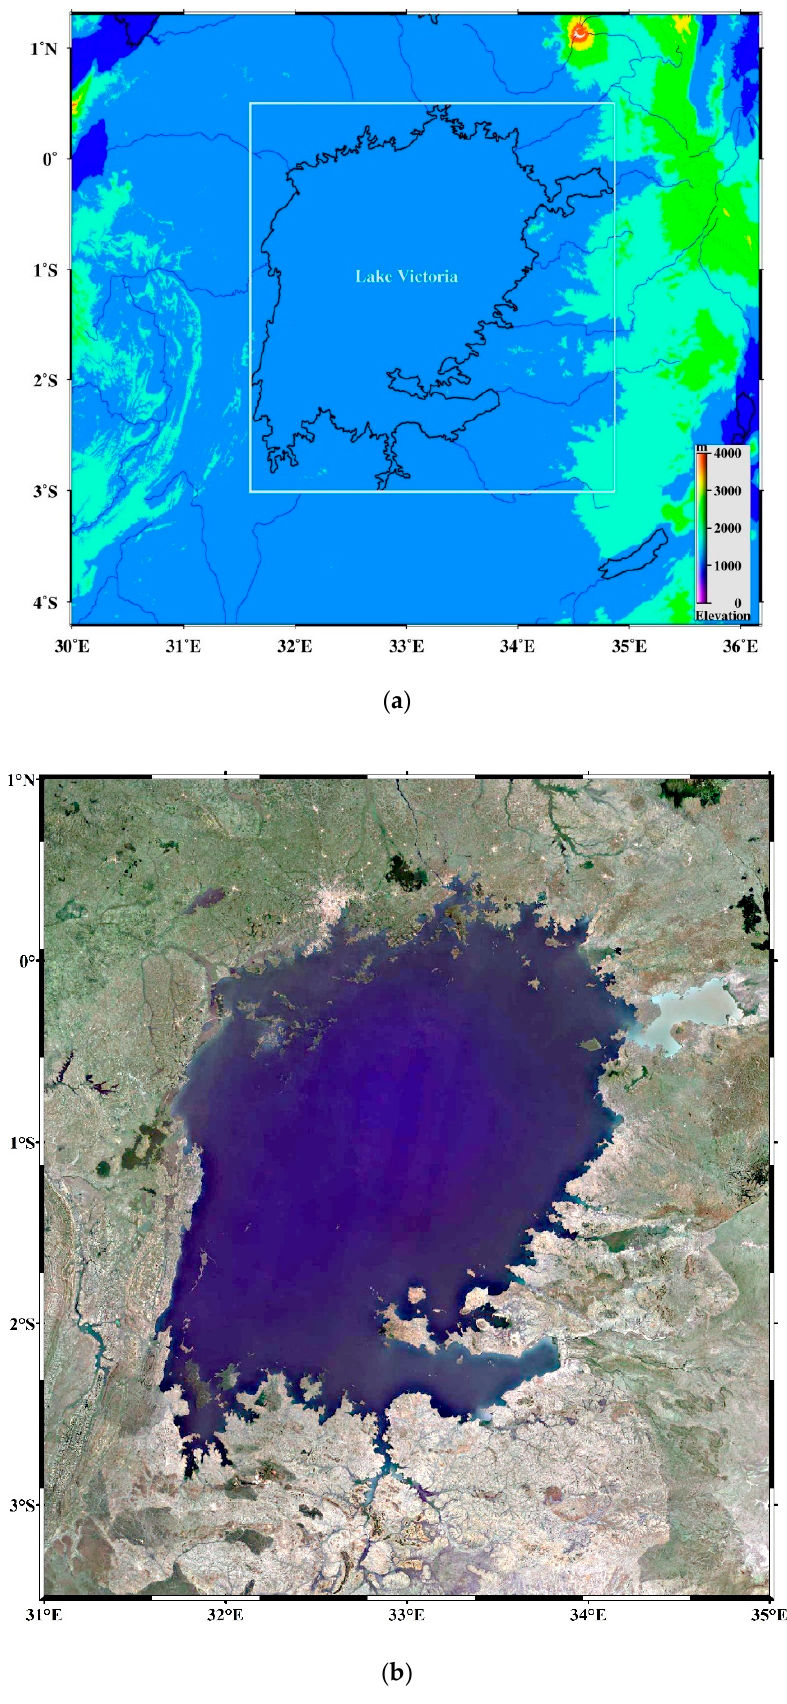
Figure 1. ( a ) The location of Lake Victoria. ( b ) Lake Victoria from Google Earth.